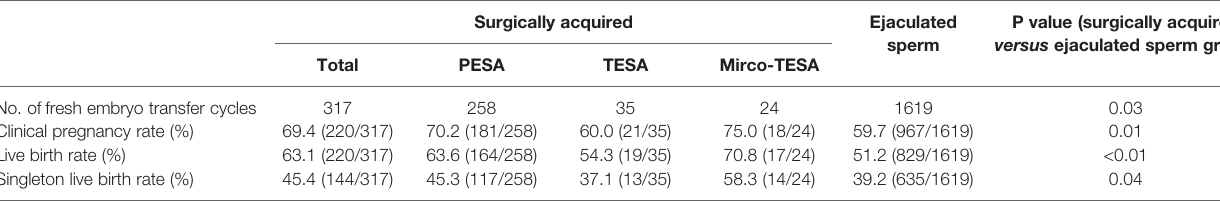
TABLE 2 | Clinical outcomes among groups.